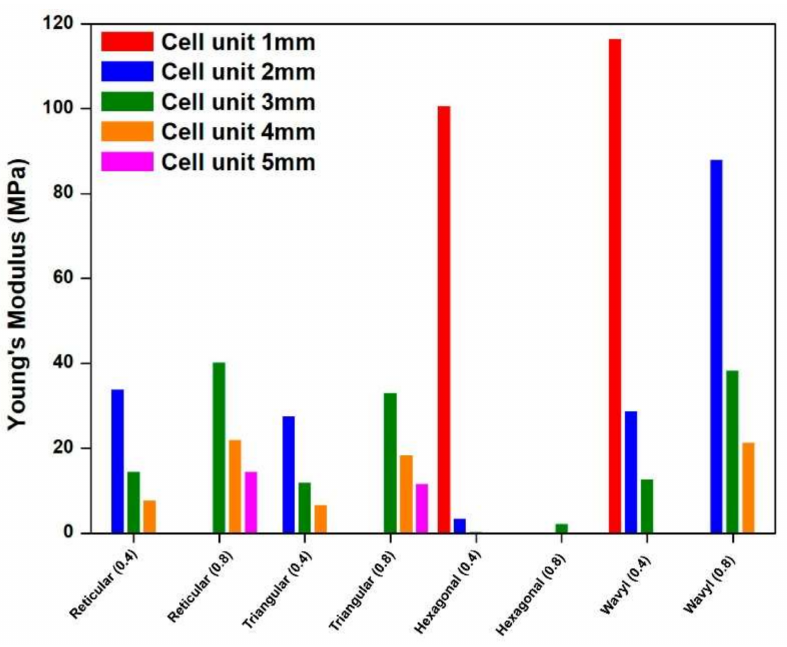
Figure 4. FEM-derived elastic modulus calculation. Elastic moduli of scaffolds with different microstructures and nozzle diameters obtained from FEM simulations. Table 1. Comparison of compressive elastic moduli ( E comp ) in the linear model of four types of scaffolds with different nozzle diameters and unit cell